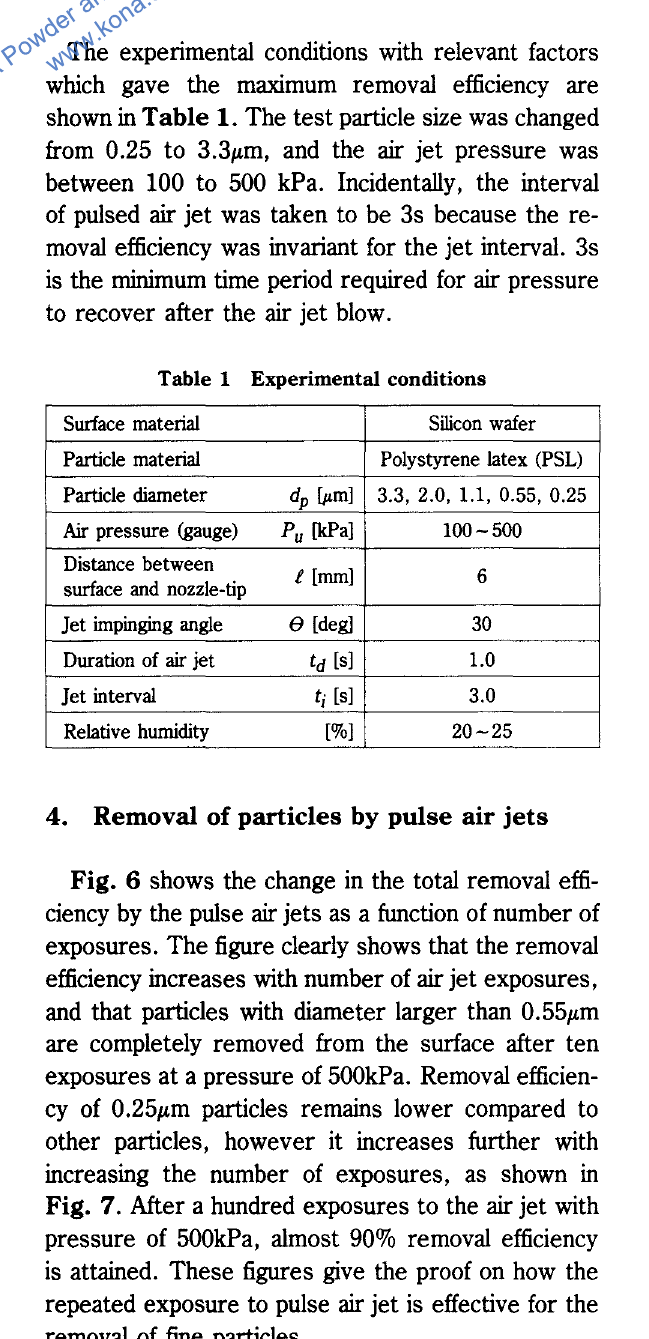
Fig. 7 Change in removal efficiency of 0.25/Lm particles with number